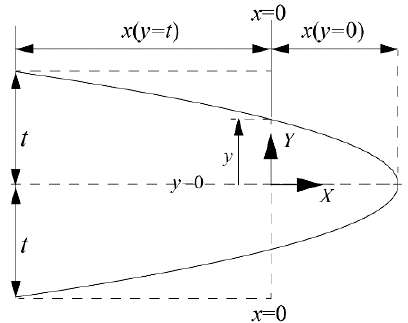
Fig. 2 Parabolic shape of the residual stress depth